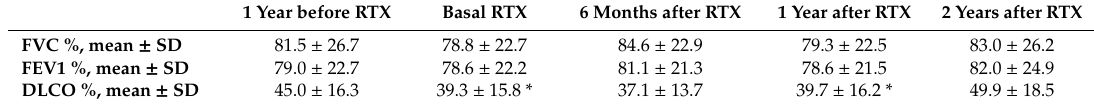
Table 2. Comparison of pulmonary function tests in 26 AD-ILD patients included in this study. 1 Year before RTX Basal RTX 6 Months after RTX 1 Year after RTX 2 Years after